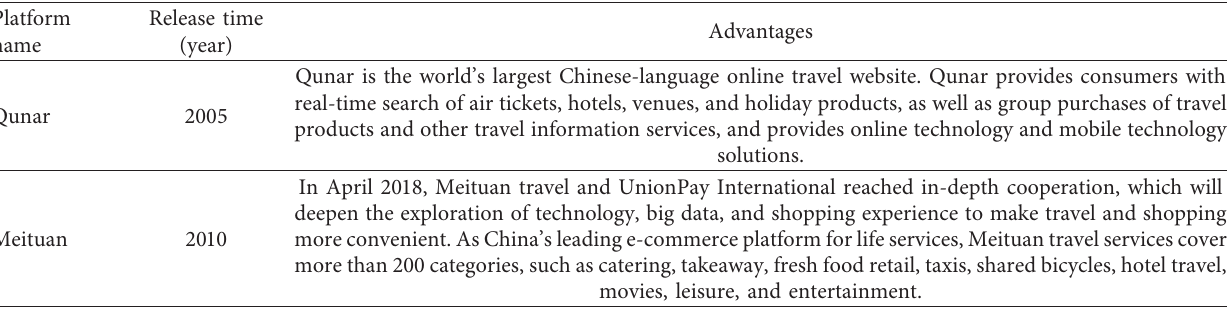
Figure 1: Comparison of the three scoring functions. Table 4: Chinese major tourism e-commerce